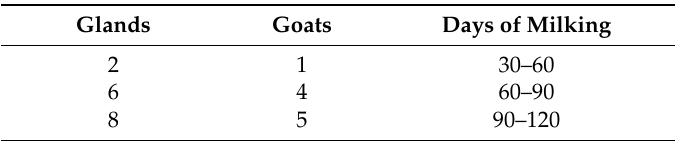
Table 5. Distribution of infected cases along mammary glands, different goats and ranges of days of